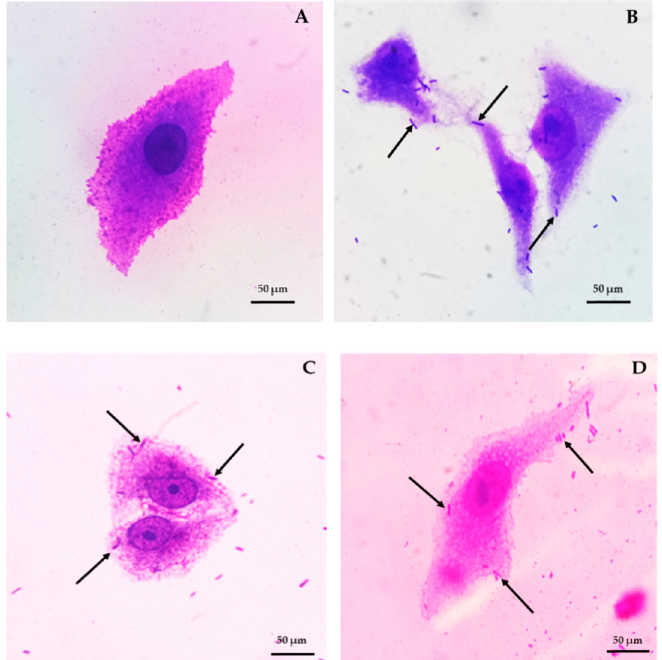
Figure 6. Vero cell control ( A ). Bacterial adeshion of L. brevis F064A ( B ), E. coli O157:H7 DMST 12743 ( C ) and Shigella dysenteriae DMST 1511 ( D ).